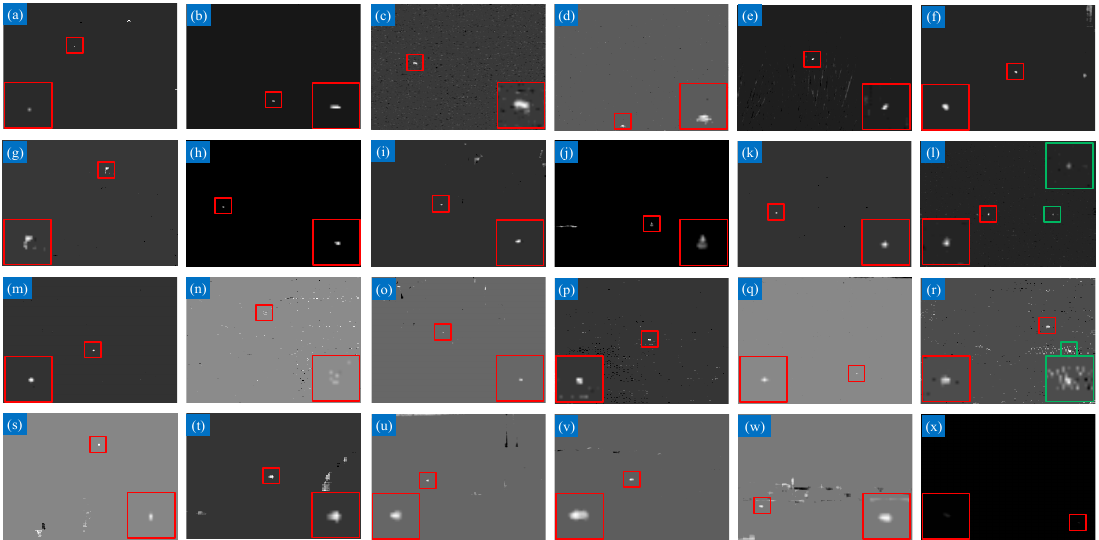
Figure A7. The separated target images of ReWIPI under 24 scenes.